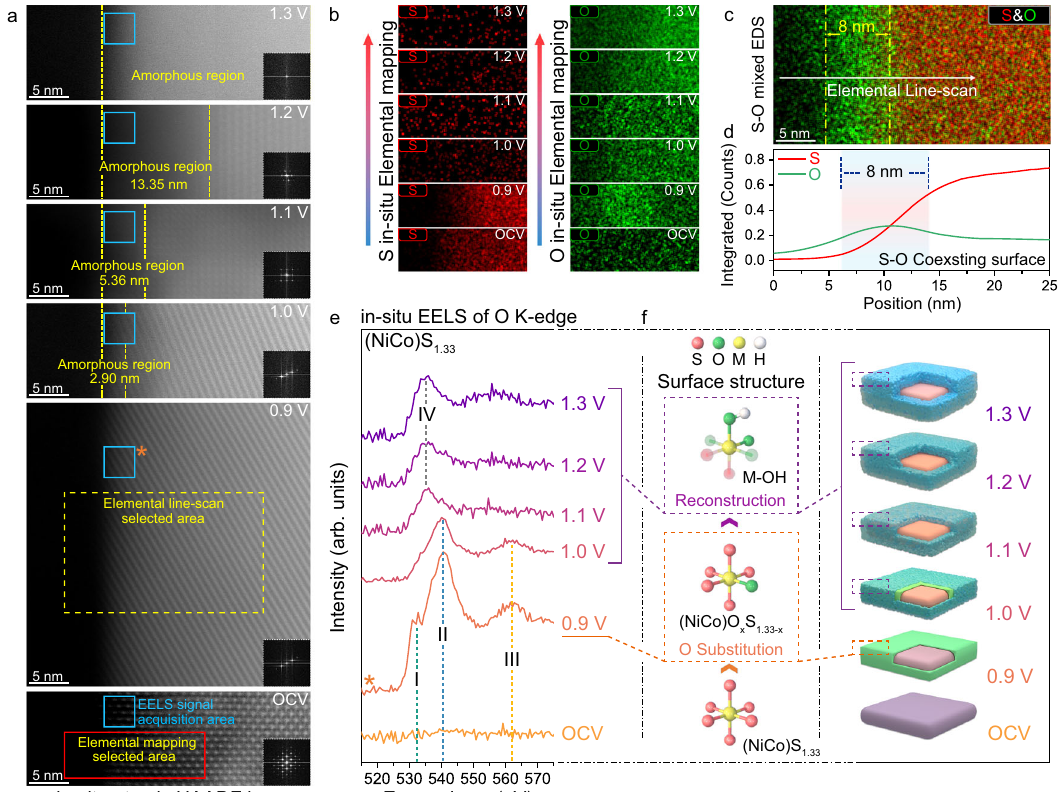
Fig. 3 | The exchange of lattice sulphur with oxygen. a In-situ atomic HAADF imagesof(NiCo)S 1.33 afterconstantlyapplyingdifferentpotentialsfor20s. b In-situ elemental mapping of S and O under different applied potentials. c S-O mixed elemental mapping of (NiCo)S 1.33 after constantly applying potentials of 0.9V for 20s. d Thecorrespondingelementaldistributioncurveextractedfrom( c ). e In-situ